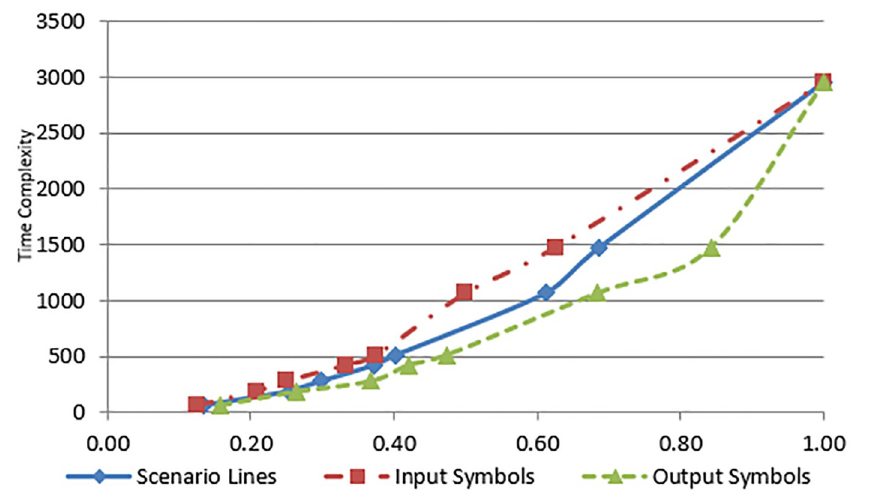
Fig 12. Time complexity to use case parameters.